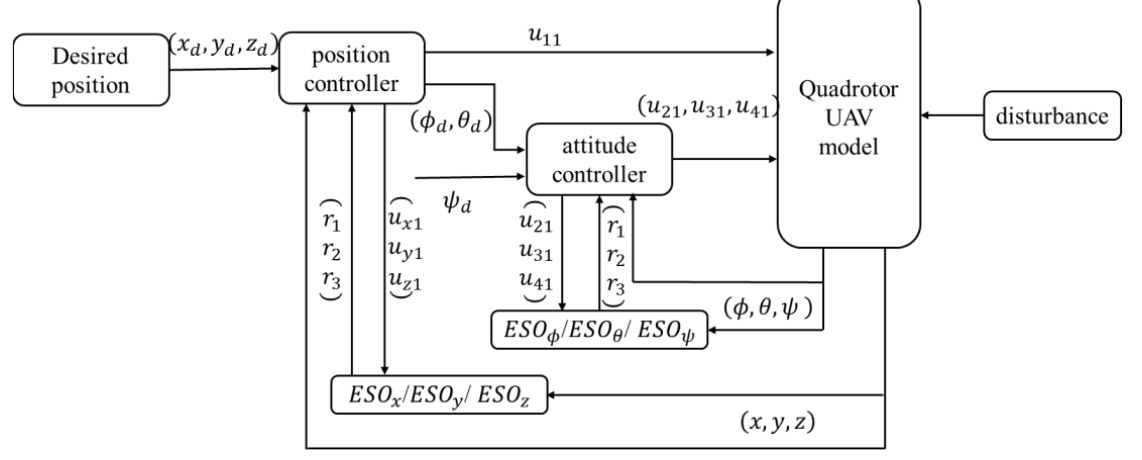
Figure 4. Control system of the quadrotor UAV based on ESO-SMC.